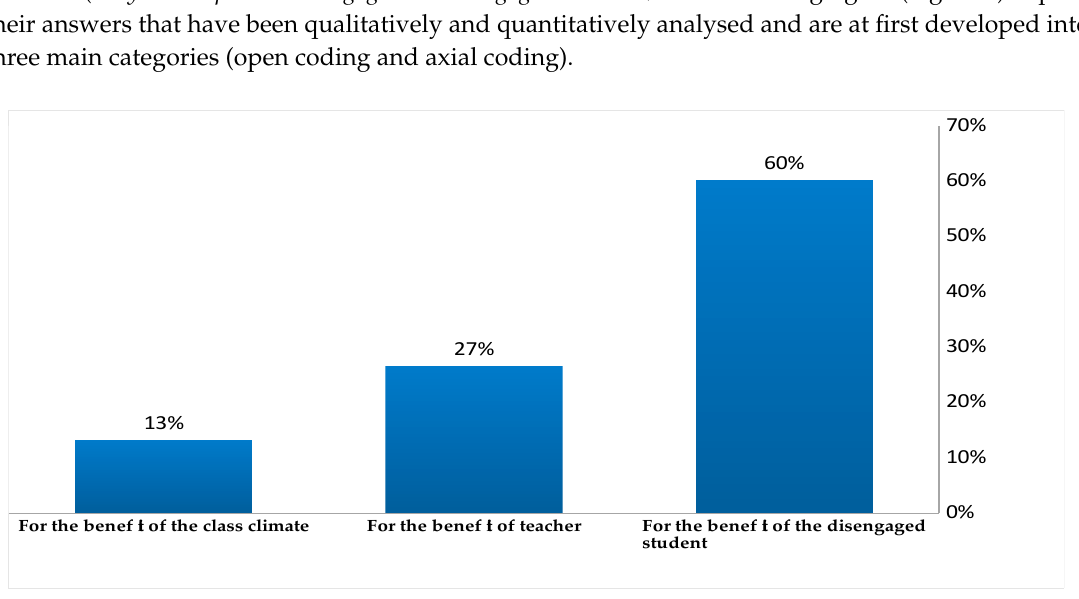
Figure 1. Teachers’ contribution to engaging each disaffected student in preschool environments.